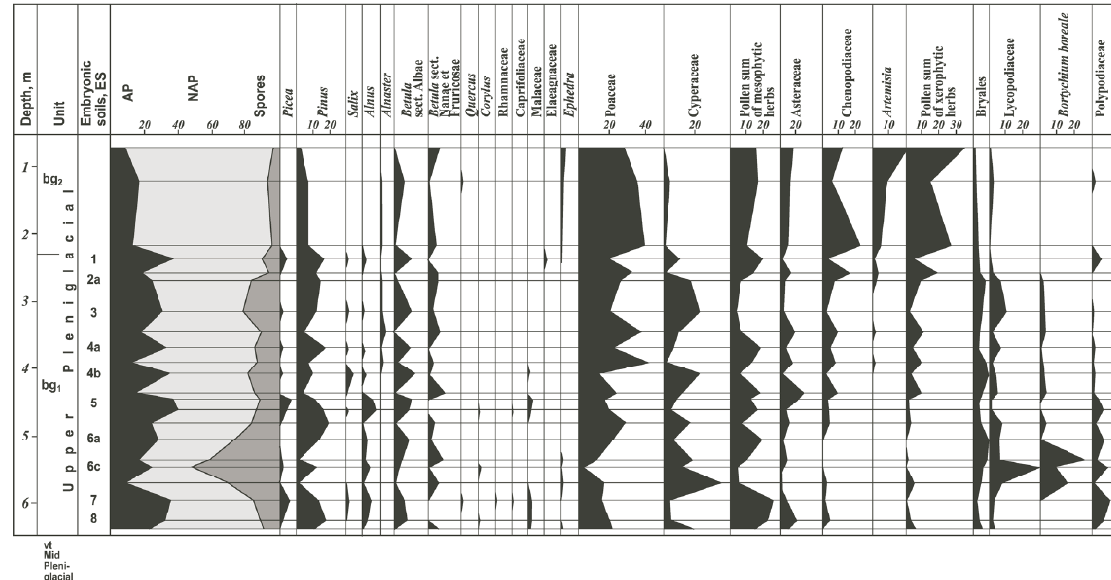
Fig. 8. Synthetic pollen diagram for the Stayky